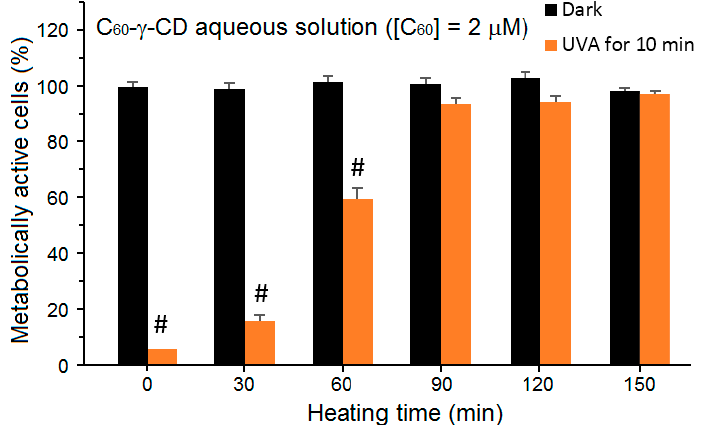
Figure 73. Effect of 2-µM fullerene water solutions as a function of heating time on the viability of HLE B-3 cells irradiated with UVA. Results were presented as the means ± SEMs from three independent experiments in quadruplicate. ** p < 0.01 and * p < 0.05 as compared with cells without fullerene treated and in the dark. # p < 0.01 as compared with corresponding cells in the dark. Adapted from Zhao; He; Chignell; Yin; Andley; Roberts [221].